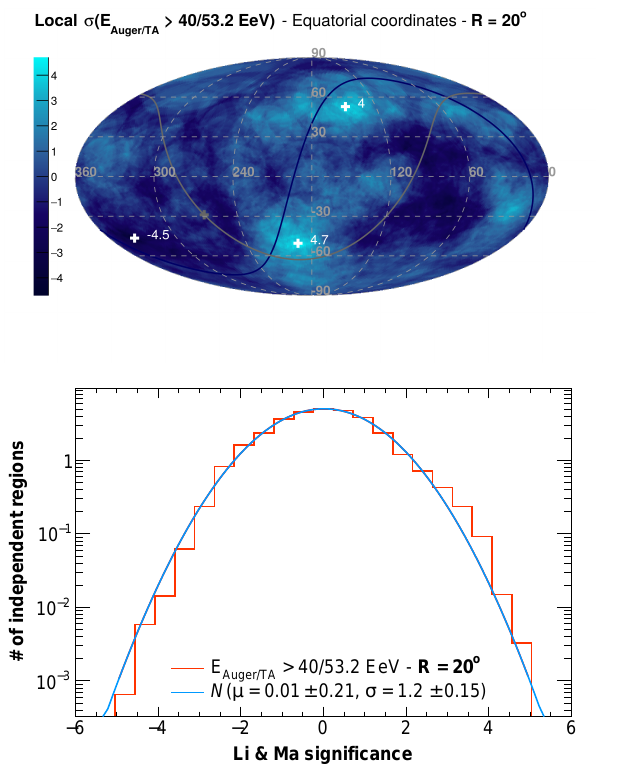
Figure 6. Top: Significance map reconstructed at E Auger / TA > 40 / 53 . 2EeV with a 15 ◦ search radius. White crosses indicate deviations from isotropy with > 4 σ local significance. Bottom: Distribution of the Li & Ma significance over the